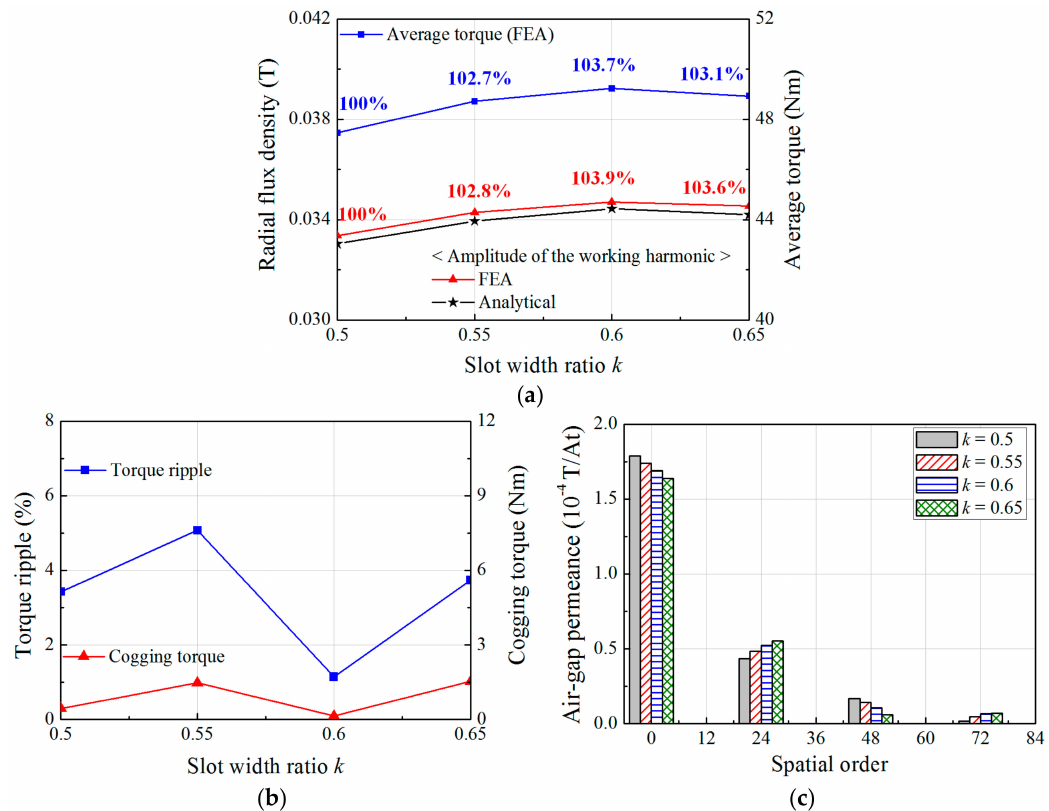
Figure 8. Characteristics of the output torque and air-gap permeance according to the slot width ratio, k . ( a ) Average torque and working harmonic; ( b ) Torque ripple and cogging torque; ( c ) Harmonic components of the air-gap permeance